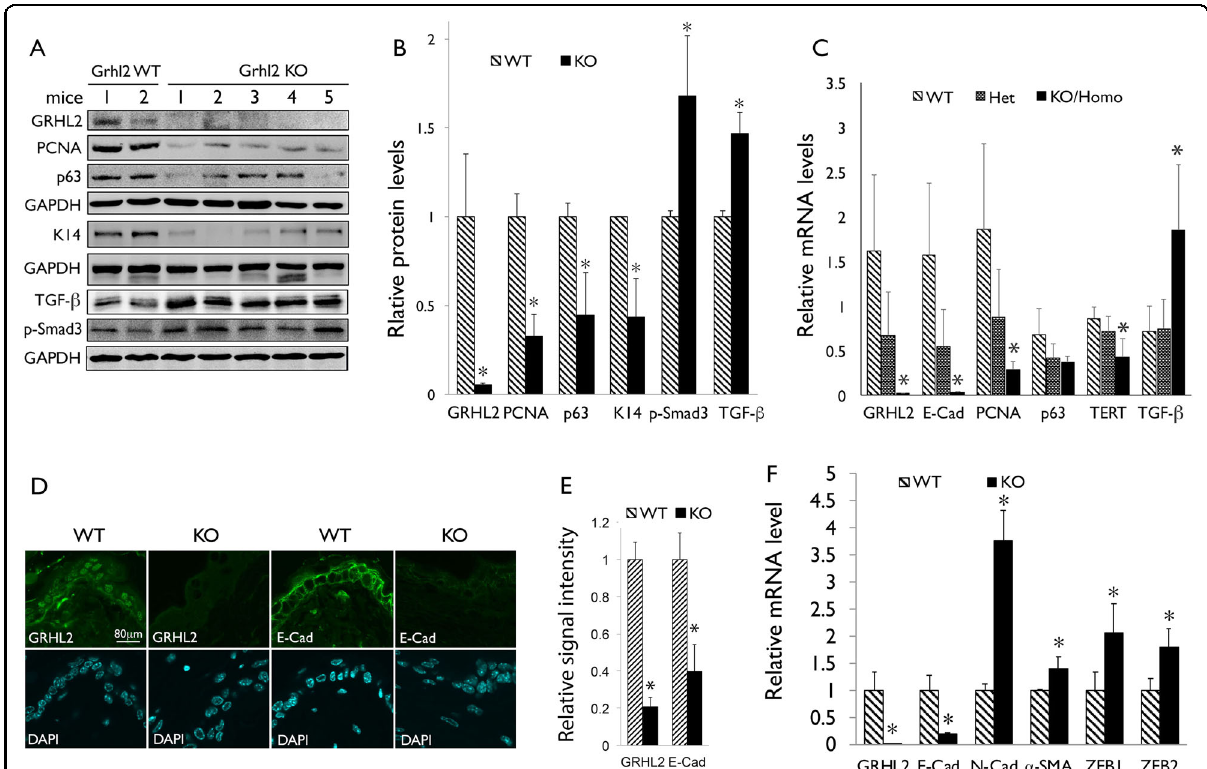
Fig. 1 Grhl2 KO suppresses epithelial phenotype marker genes and induces TGF- β signaling in epithelial tissues in vivo. a Western blotting was performed with epidermal tissues isolated from Grhl2 WT and Grhl2 KO mice for GRHL2 and various target proteins, e.g., PCNA, p63, K14, and Sox2, as well as TGF- β and p-Smad3. b Western blotting signals were quantitated by densitometric analysis and plotted with the mean values for Grhl2 WT and KO mice groups. Bar indicates mean/SD, * P o 0.05. c Quantitative reverse transcription-PCR (qRT-PCR) was performed with total RNAs isolated from Grhl2 WT, Grhl2 heterozygote (±) and Grhl2 KO mouse epidermis. Data were derived from three independent experiments and qRT-PCR assays were performed in triplicates. d IFS was performed for GRHL2 and E-Cad in skin epithelia of Grhl2 WT and KO mice. e IFS signals were quantitated and plotted with the mean values for Grhl2 WT and KO mice groups. f qRT-PCR was performed with tongue epithelium harvested from Grhl2 WT mice ( n = 3) and Grhl2 KO mice ( n = 3) for various markers of mesenchyme, e.g., N-Cad, α -SMA, ZEB1, and ZEB2. Bar indicates mean/SD. * P o 0.05, statistical signi fi cance, compared with WT